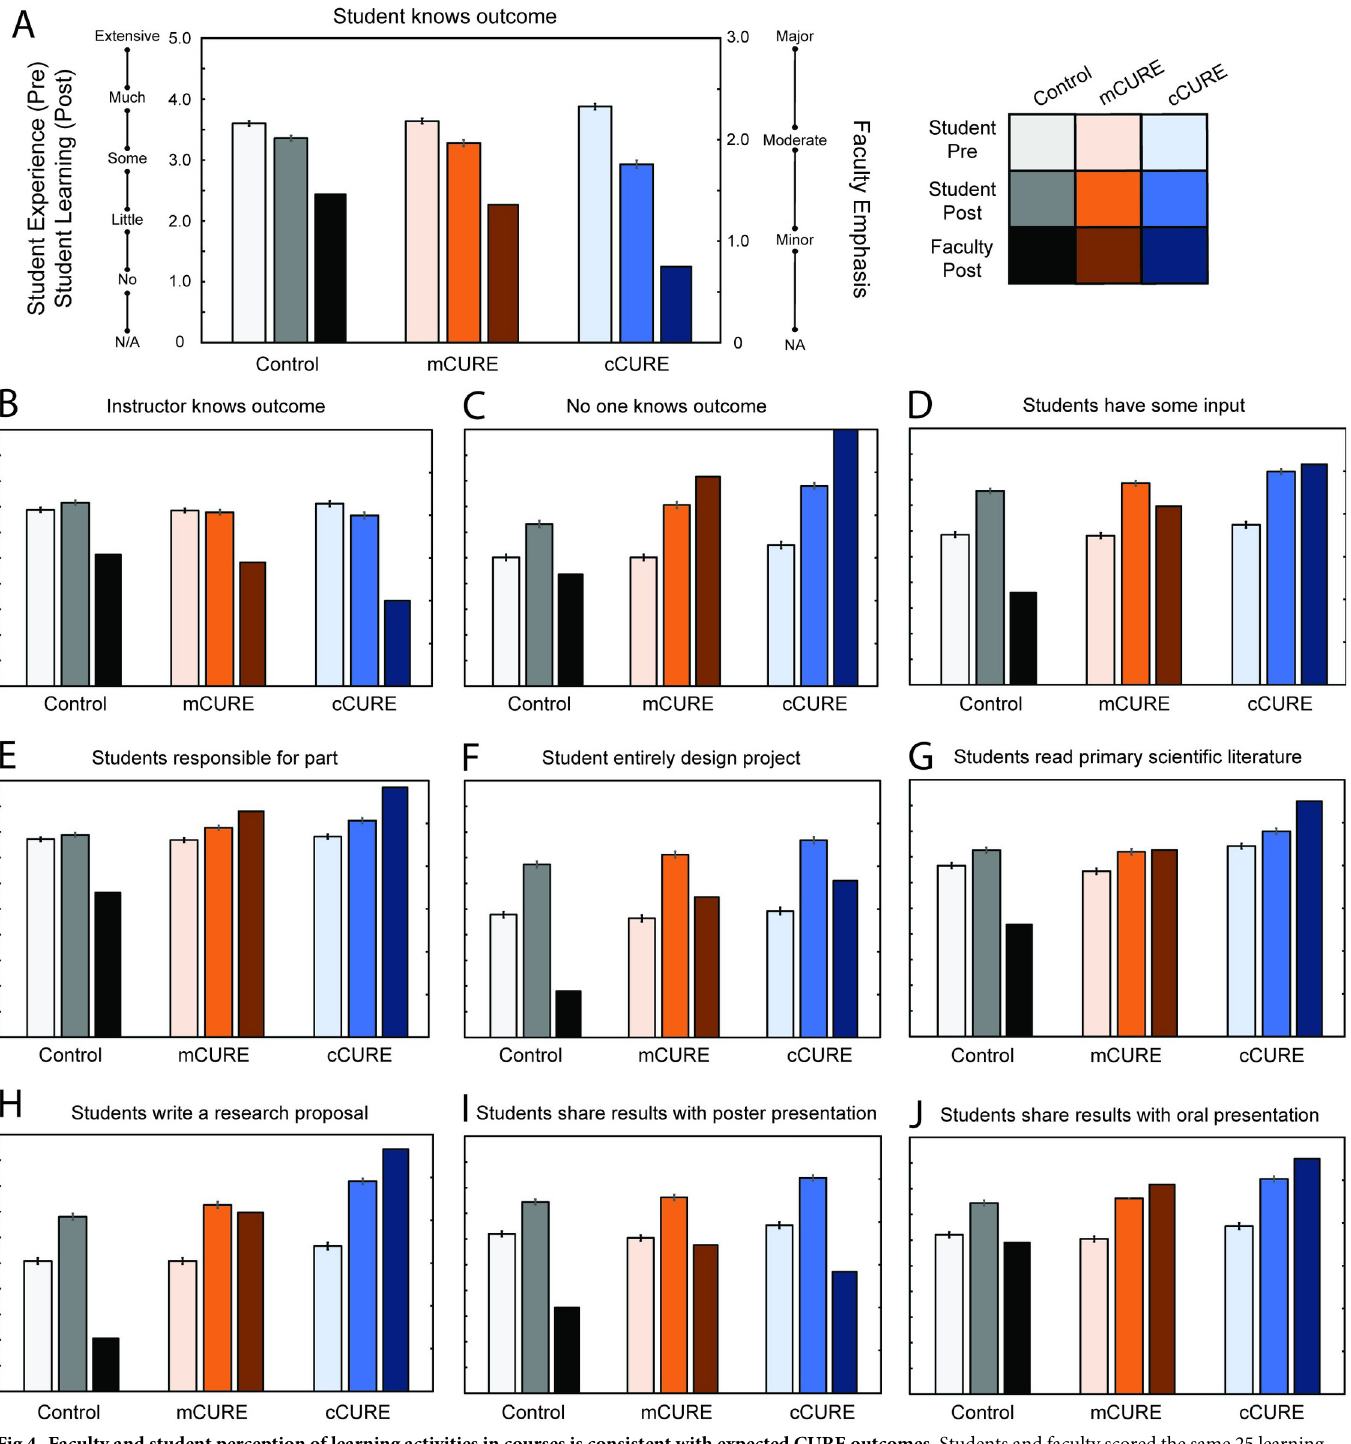
Fig 4. Faculty and student perception of learning activities in courses is consistent with expected CURE outcomes. Students and faculty scored the same 25 learning activities in their classes. On the pretest, students scored each activity on their level of experience with that activity prior to the course (1 = no experience or feel inexperienced to 5 = extensive experience or mastered this element). On the posttest, students scored each activity on how much learning they gained from the activity in their class (1 = no gain or very small gain to 5 = very large gain). After the course, faculty scored how much emphasis they placed on the learning activity on a scale of 0 (not applicable) to 3 (major). An ANCOVA controlling for pretest scores and incorporating a Bonferroni correction for 25 tests ( p < 0.002) indicated ten learning activities that were significantly different between conditions as reported by students. These ten learning activities are from three groups: 1) knowledge of experimental